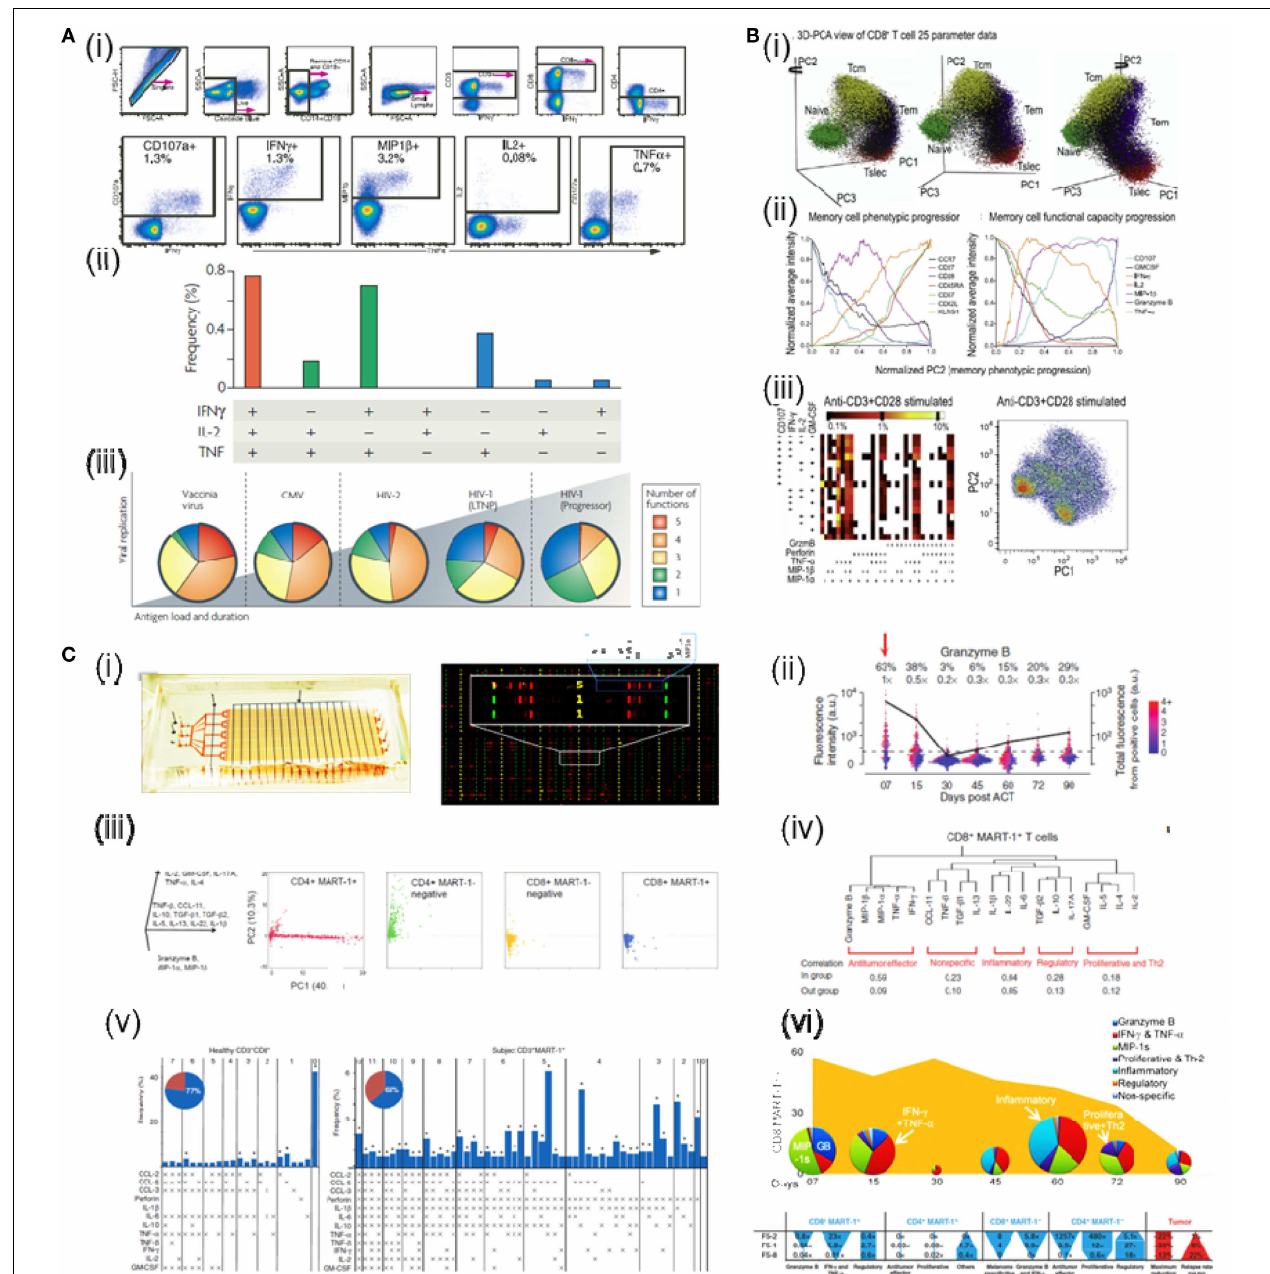
represents the log scale frequency of cells displaying each combination of functional capacity. Right: psuedo-colored density-dot plots of the first two principal components are shown for cells stimulated with anti-CD3 + anti-CD28. (C) Dynamics of antitumor immune response measured by SCBC. (i) The design of the single cell barcode chip (left) and sample image readout of cell cytokine production (right). (ii) Gated and background subtracted one-dimensional scatterplots of a representative cytokines produced by single cells at different time. (iii) Cytokine secretion florescence intensity data analyzed by PCA. (iv) Hierarchical clustering of the 19 functional cytokines produced by CD8T cells. (v) Functional diversity plots for antitumor CD8T cells. (vi) Time-dependent changes ofT cell cytokine polyfunctional strength and comparison between three patients analyzed. (Reprint permission obtained where